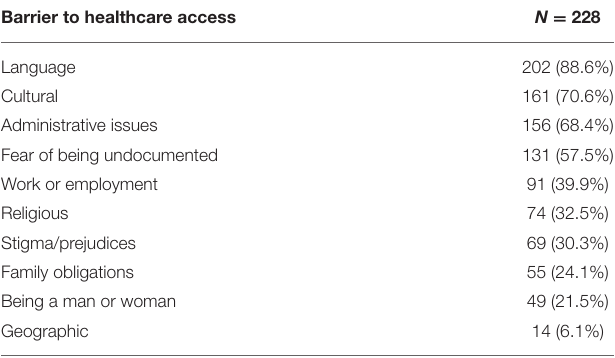
TABLE 1 | Professionals’ responses to the question, “what barriers/problems/difficulties does the migrant population face when accessing health services?